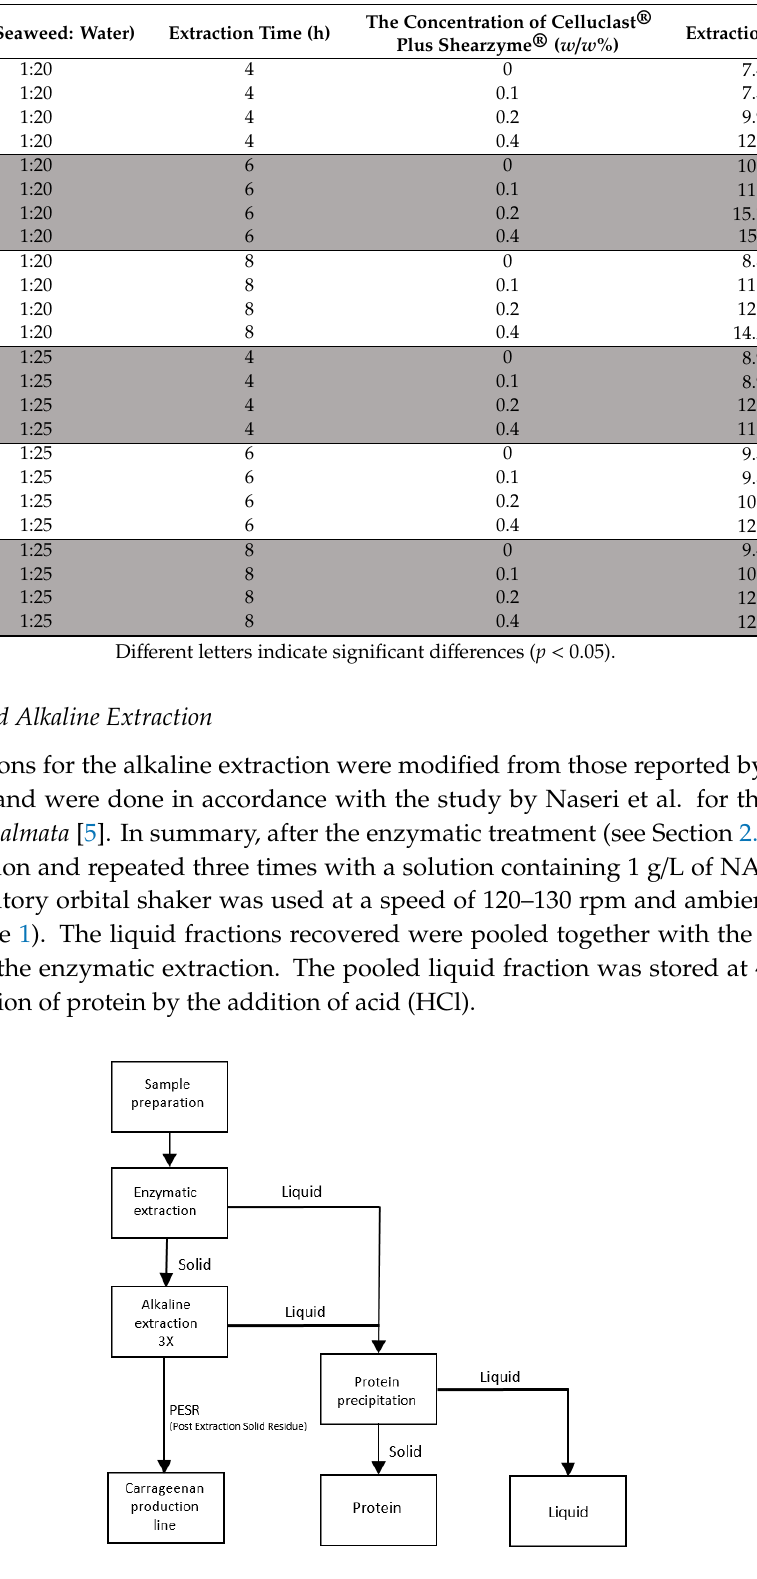
Figure 1. Process flow diagram for a proposed multi-extraction process of seaweed with both enzymatic extraction of proteins, followed by NAC assisted alkaline extraction before the actual industrial utilization of the spinosum seaweed for carrageenan